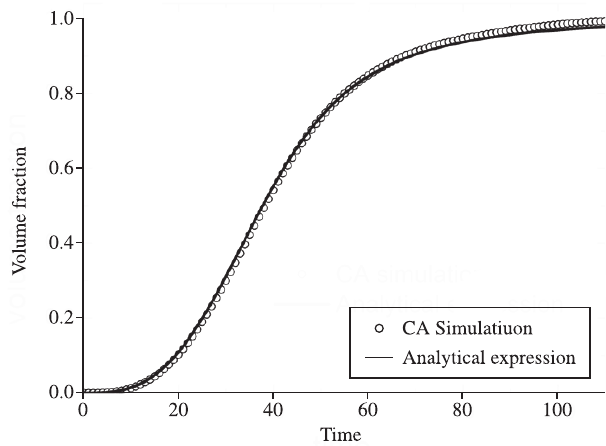
Figure 6. The volume fraction, V with analytical